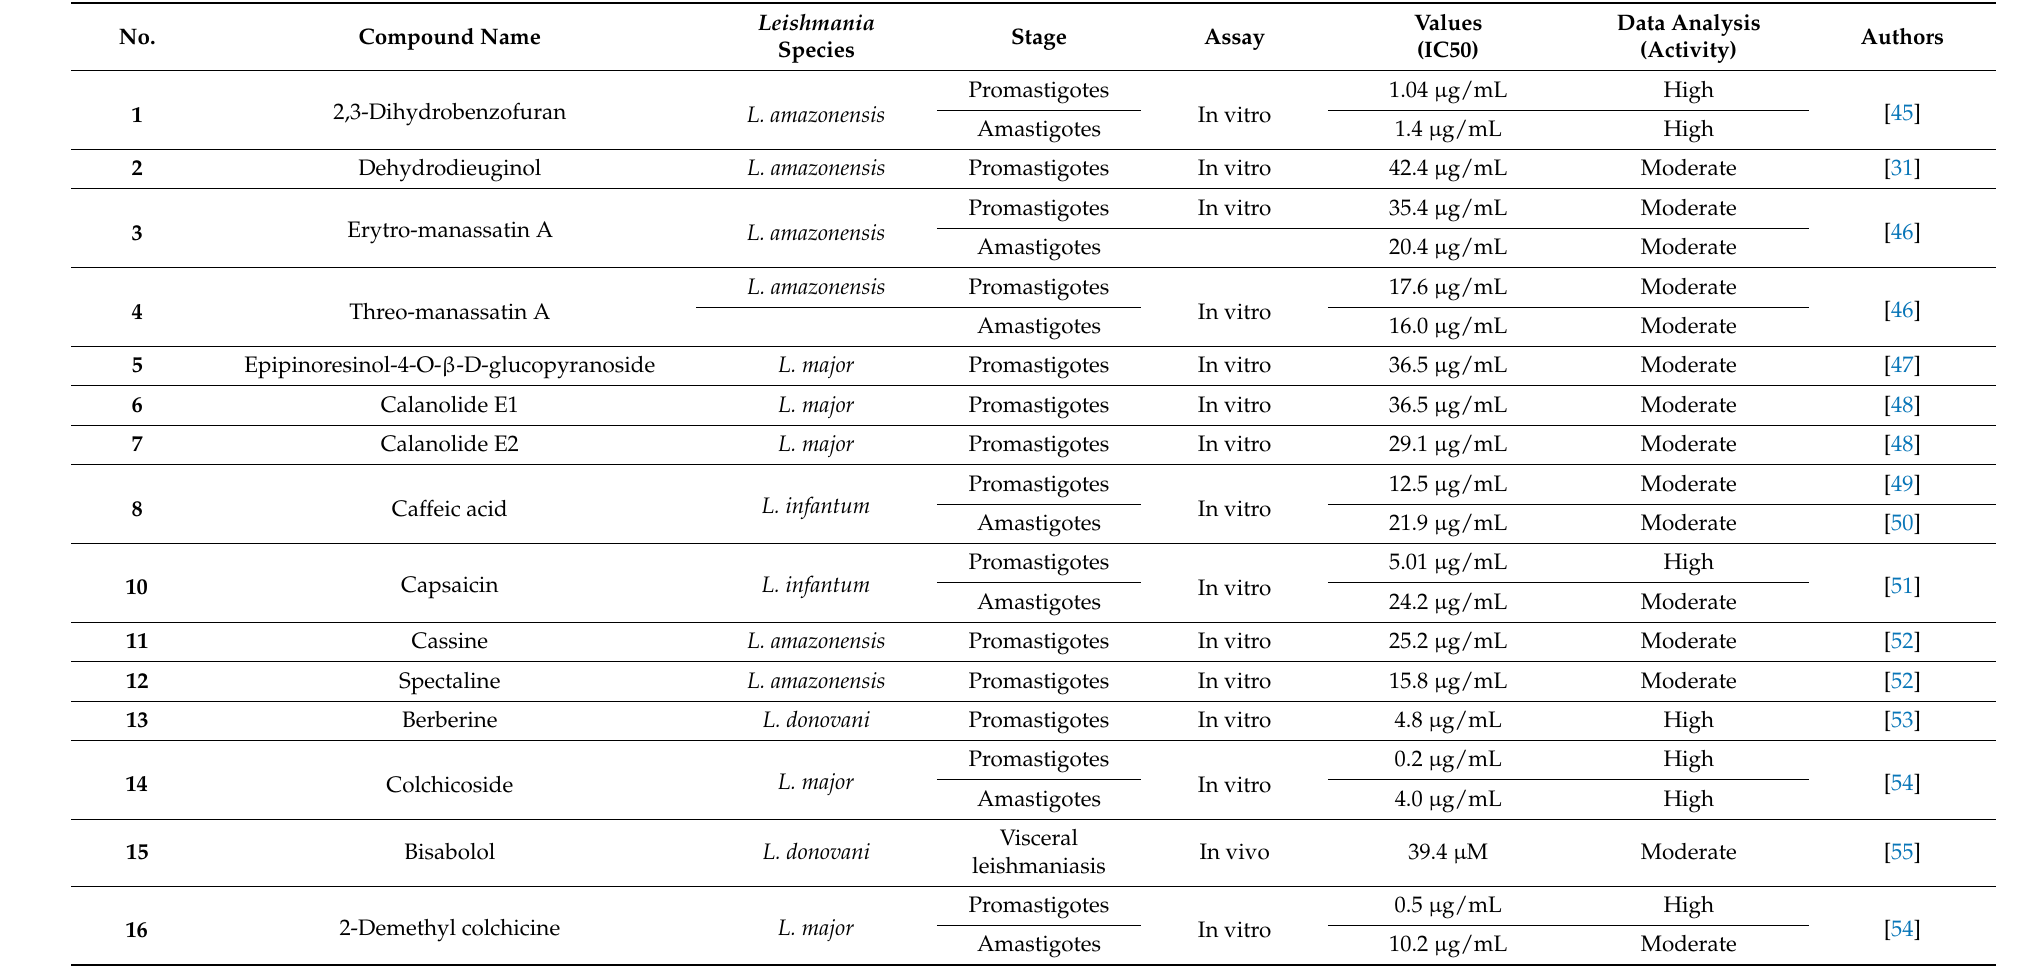
Table 6. Anti- Leishmania activity of isolated natural